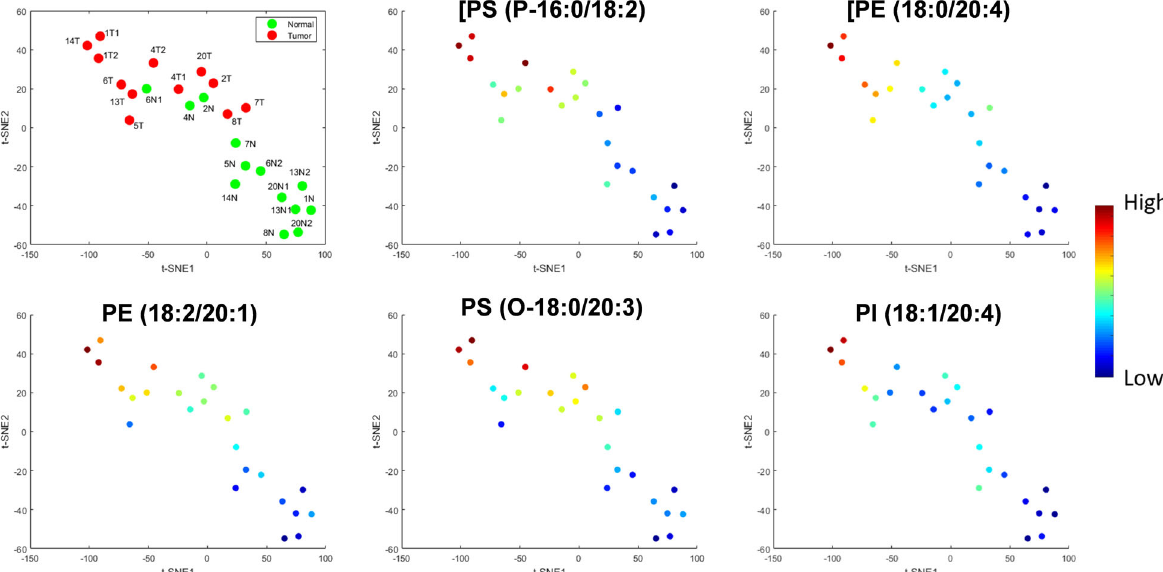
Fig. 5 t-distributed stochastic neighbor embedding (t-SNE) demonstrating the placement of each specimen as a data point in an unsupervised manner based on the 5 most discriminant features. Data points are labeled by their case number followed by N (normal) in green or T (tumor) in red, and then by sample number if there was more than one specimen for that designation. The data points were then colored based on the ion intensities of the fi ve signi fi cant lipid